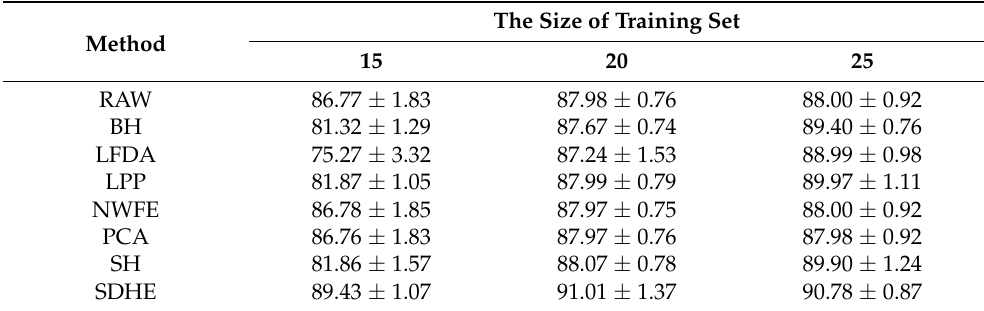
Table 8. Classification accuracy (%) at 30-dimensionality for the different sizes of training sets in